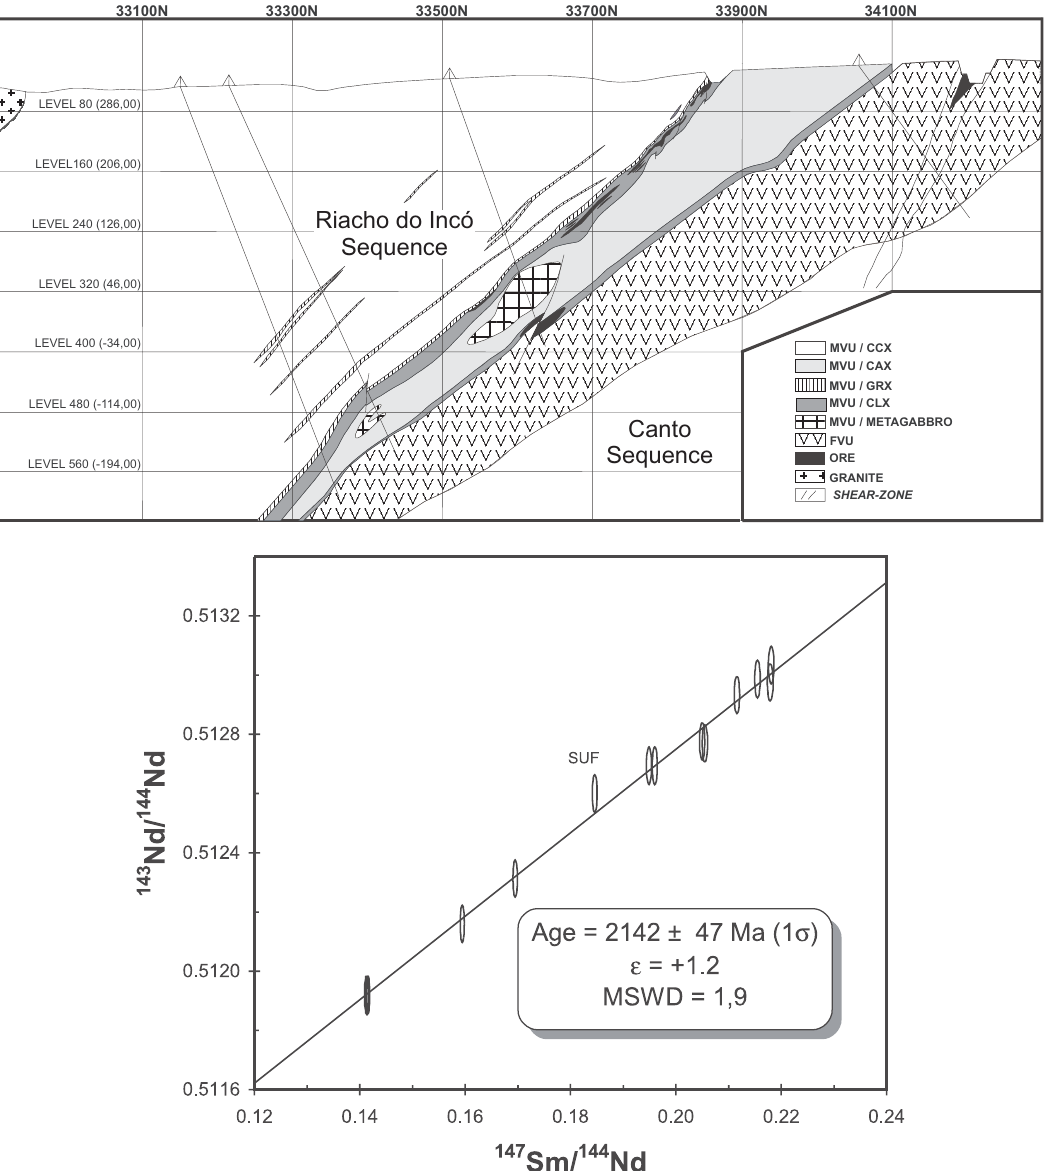
Fig. 3 – Cross section of the Fazenda Brasileiro mineralization and the Sm-Nd whole-rock isochron for the gabbro host-rock (after Silva et al. 2001b). MVU – mafic volcanic unit, CCX – carbonate chlorite schist, CAX – carbonate albite schist, GRX – garnet schist, CLX – chlorite schist, FVU – felsic volcanic unit.